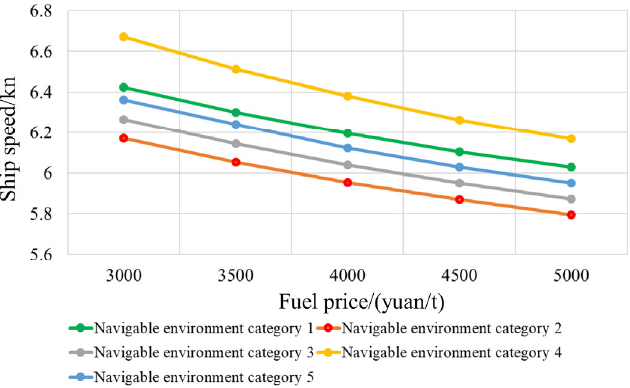
Figure 15. Optimal speeds for different environmental categories at different fuel prices.